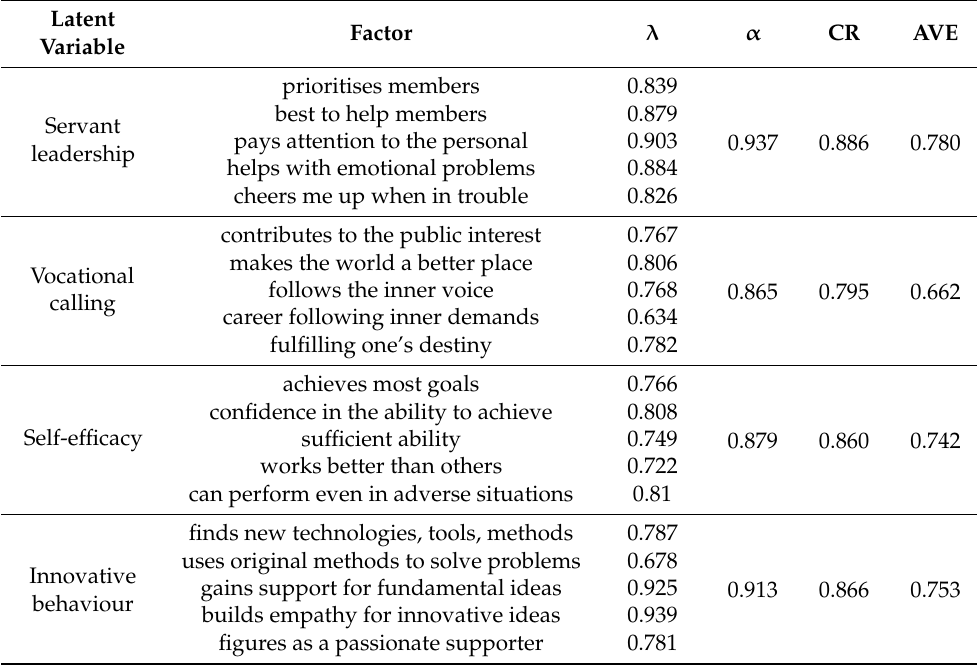
Table 3. Confirmatory factor analysis and reliability analysis of the entire composition